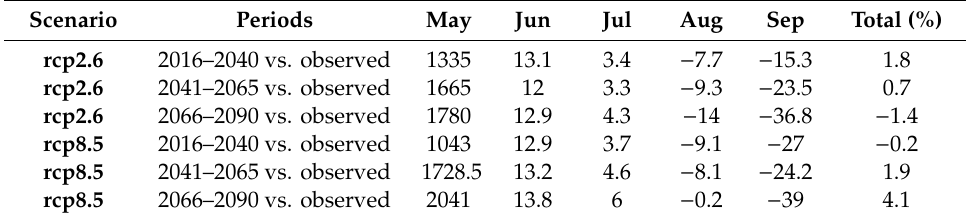
Table 8. Change values of the irrigation water requirement (IR) of fodder maize under scenarios rcp2.6 and